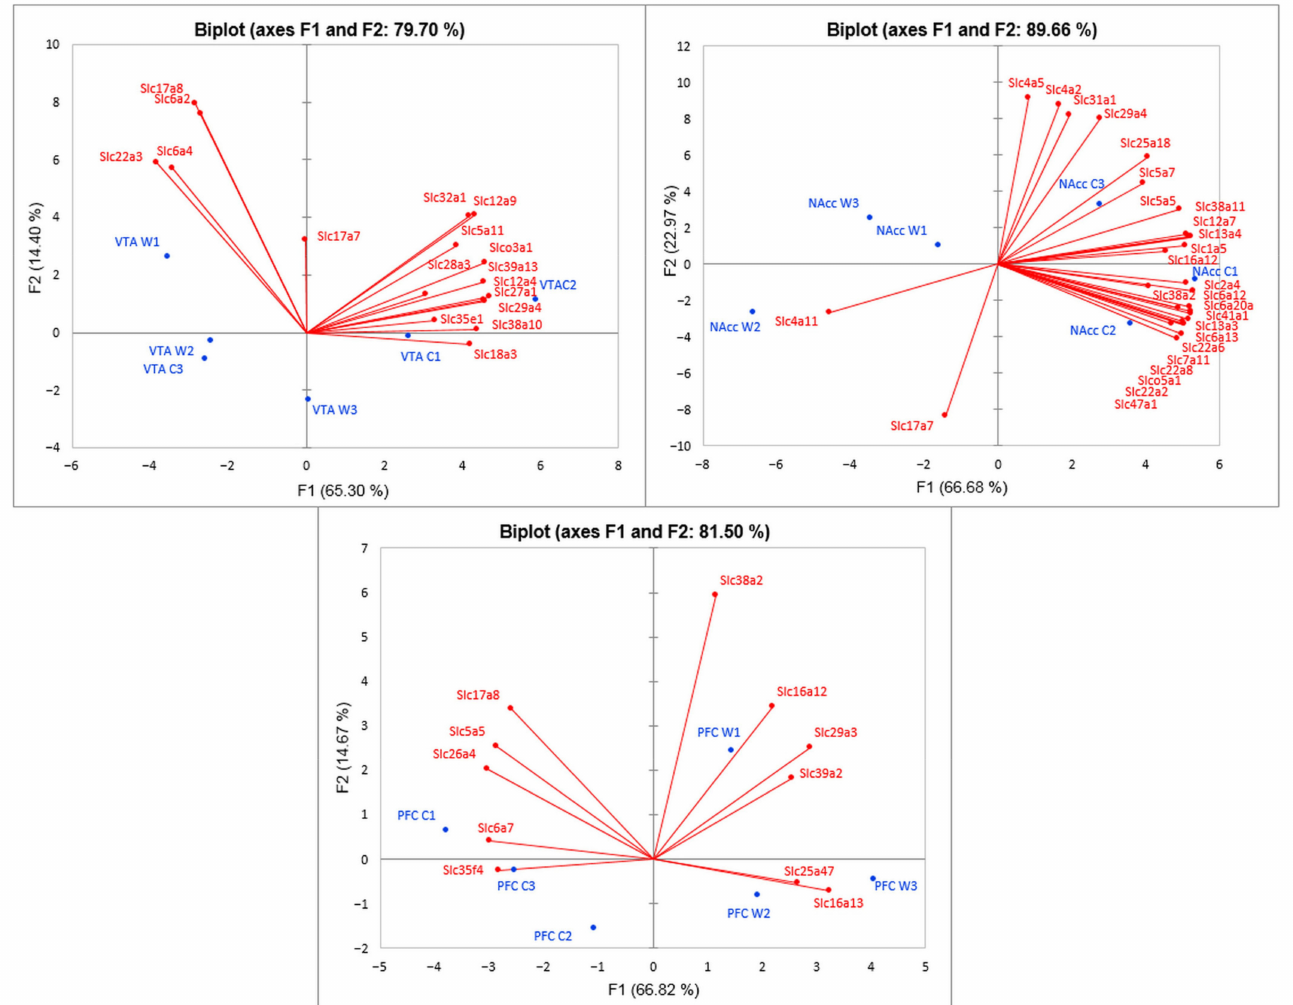
Figure 6. PCA biplot based on covariation of Slc DEGs using the expression profiles, which comprised RNA-Seq FPKM data for three brain regions. Red points: active variables; Blue points: active observations. W1, W2, W3: winners; C1, C2, C3: controls. Figure demonstrates distinct intergroup clustering of Slc DEGs. VTA: ventral tegmental area, NAcc: nucleus accumbens; PFC: prefrontal